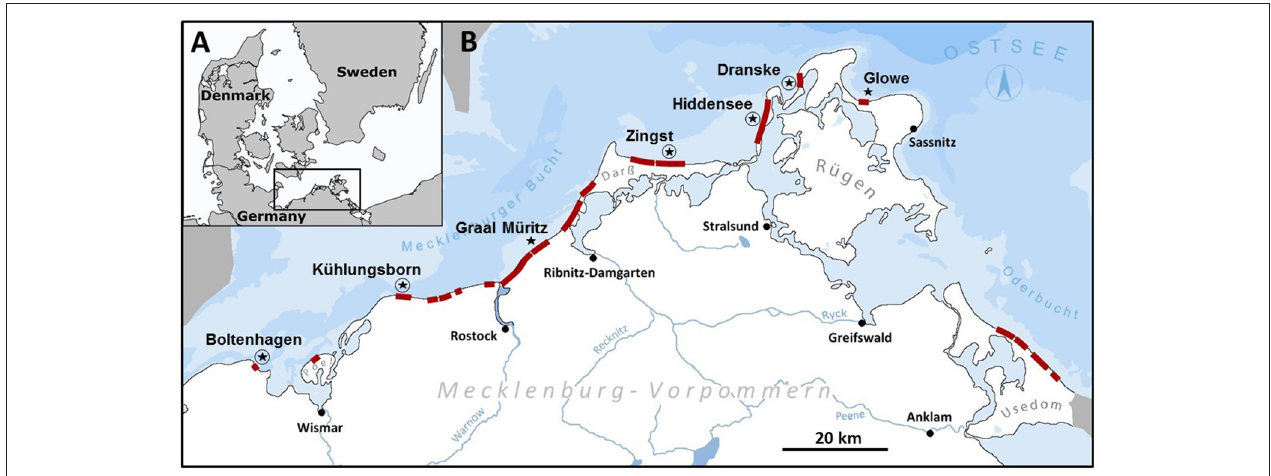
FIGURE 1 | Sampling area: (A) Position of the sampling area on the southern Baltic Sea coast. (B) Sampling area: Red bars indicate groin systems in the sampling area. Stars mark sampling locations with only test panels, and stars with circles indicate sampling locations where test panels and data loggers were installed in